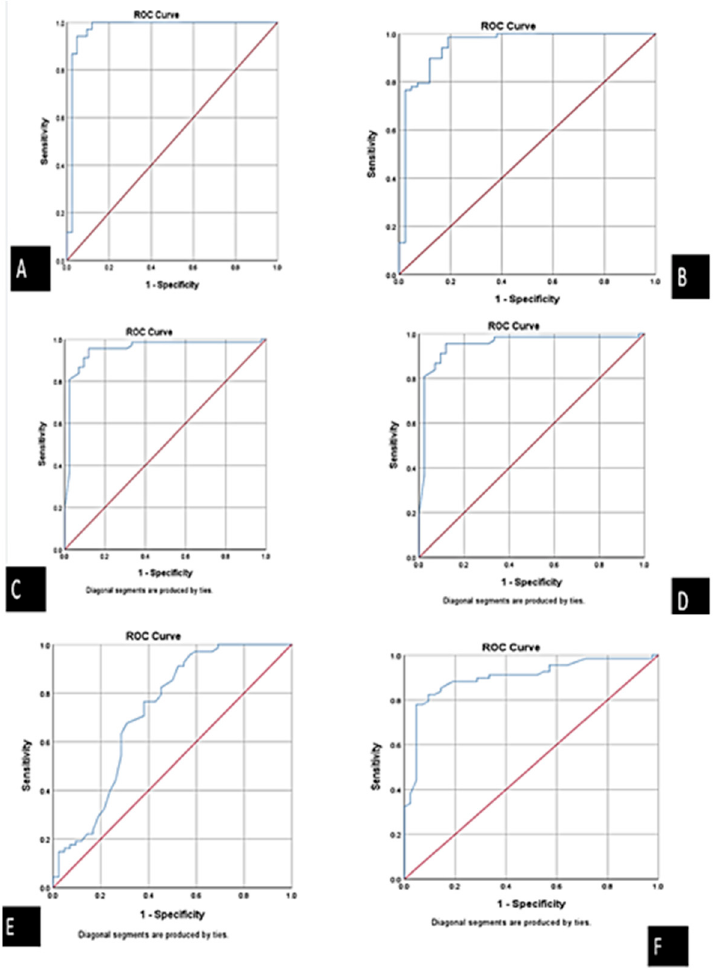
Figure 2. Receiver operator characteristics (ROC) curve presents the diagnostic accuracy of the ABHD4 RNA panel discriminating between ACS and control. ( A ) ABHD4 mRNA , ( B ) MiRNA-197-5p , ( C ) miRNA-221-3p , and ( D ) FENDRR lncRNA , ( E ) CK-MB, and ( F ) cardiac troponin.